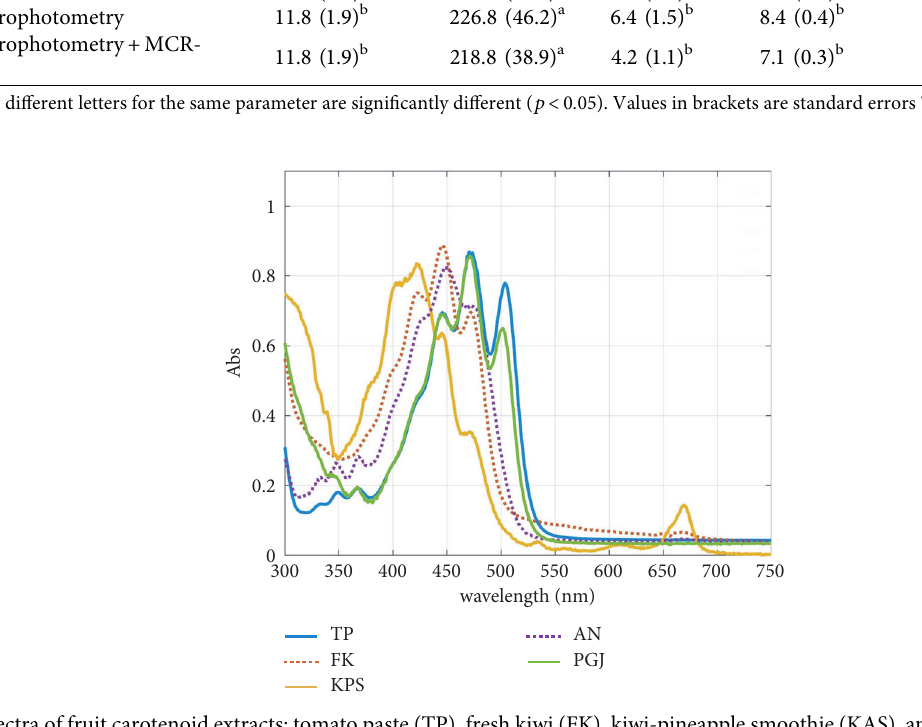
Figure 5: Spectra of fruit carotenoid extracts: tomato paste (TP), fresh kiwi (FK), kiwi-pineapple smoothie (KAS), apricot nectar (AN), and pink grapefruit juice